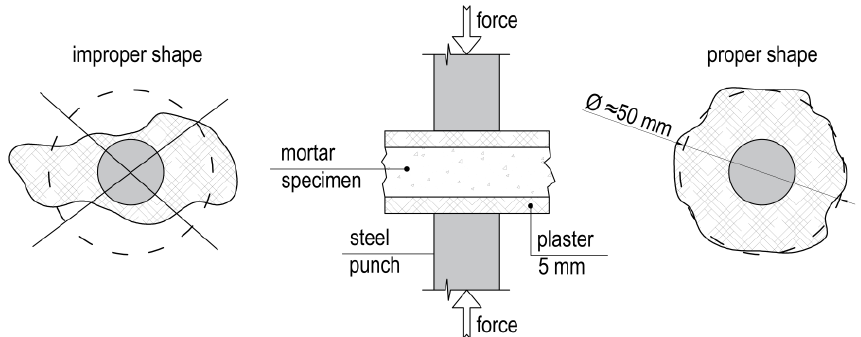
Figure 1. The idea of DPT—compression test through steel punches. Specimen suitable for test should have about 50 mm in diameter and both surfaces leveled.